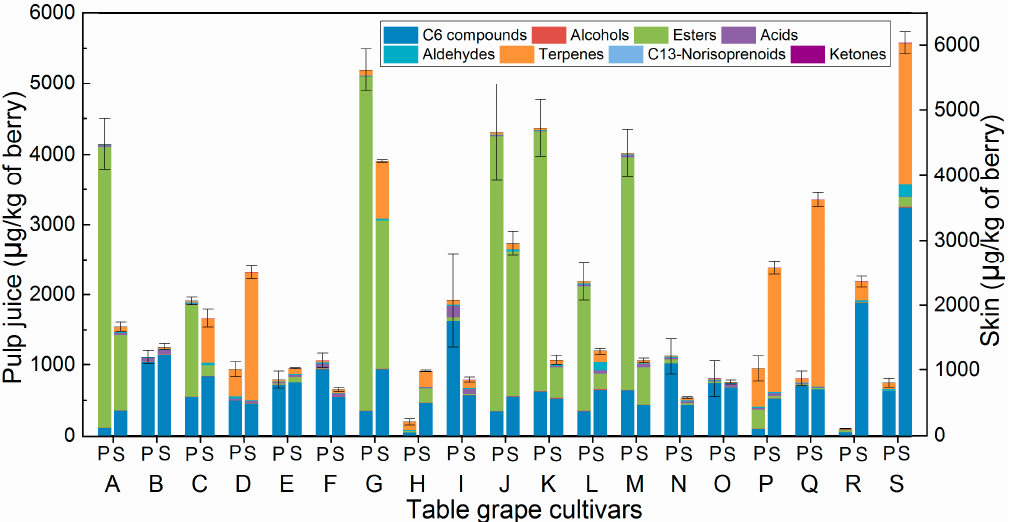
Figure 2. Each class of volatile compound as measured in the pulp juice (P) and skin (S) of unfamiliar table-grape cultivars. The results are shown as mean values. The error bars represent the standard deviation ( n = 3 biological replications). Capital letters refer to table-grape cultivars, as listed in Figure 1.